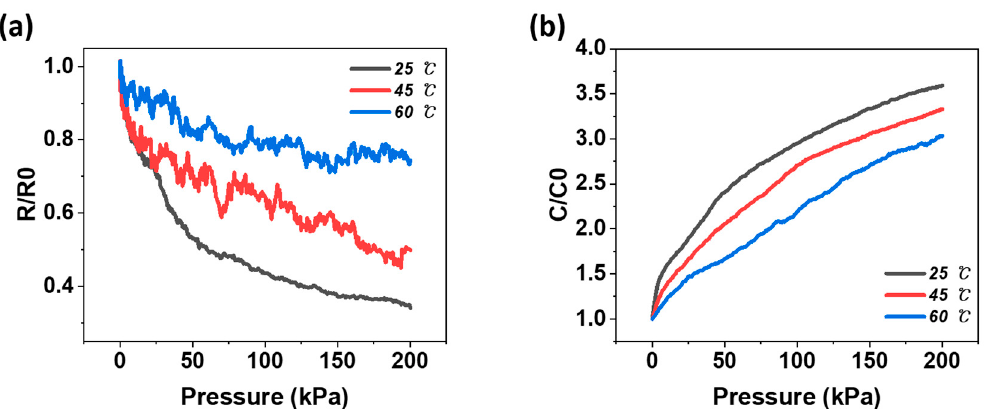
Figure 7. Change in ( a ) resistance ( R / R 0 ) and ( b ) capacitance ( C / C 0 ) versus pressure for 3 wt% CNT/PDMS for the reference group (25 °C, 45 °C, and 60 °C).